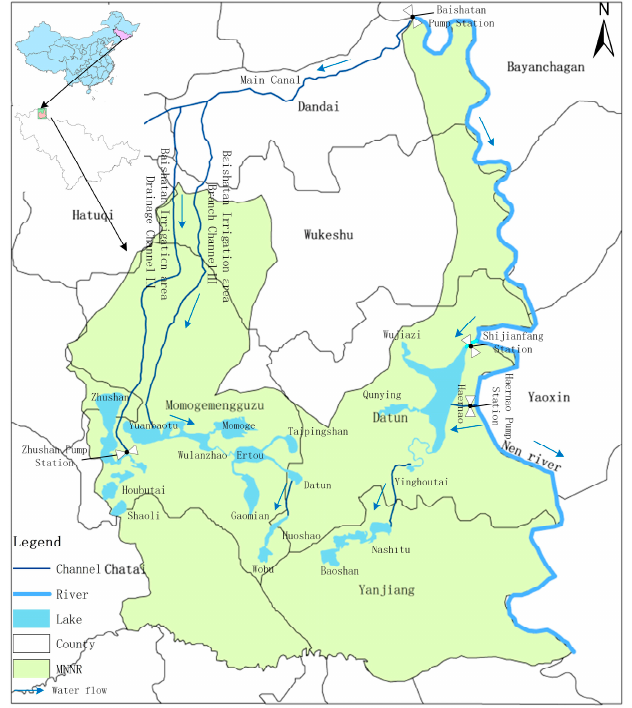
Figure 2. Schematic diagram of water supplement route in Momoge National Nature Reserve (MNNR).